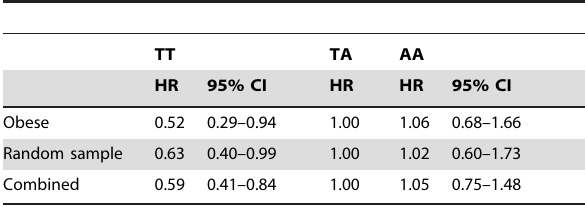
Table 2. FTO rs9939609 genotype distribution and all-cause mortality in 1,628 Danish men